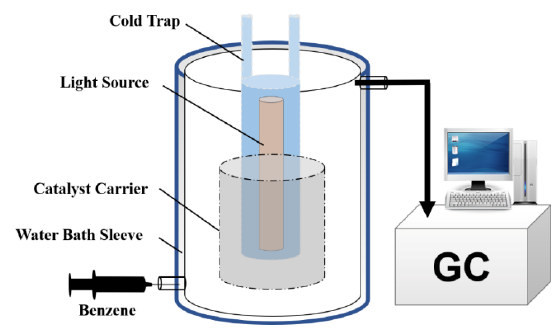
Figure 12. Benzene gas photocatalytic reactor.